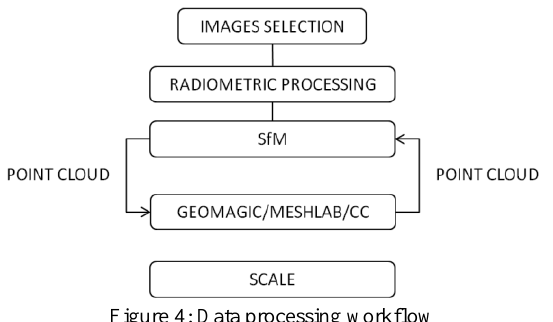
Figure 4: Data processing workflow